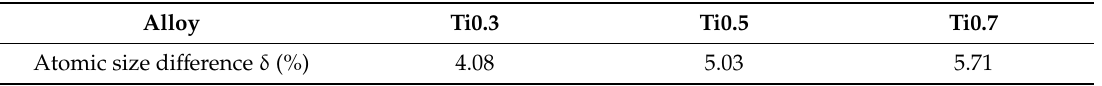
Table 7. The calculated atomic size di ff erence of produced Ni 1.5 Co 1.5 CrFeTi X alloys in a single-phase